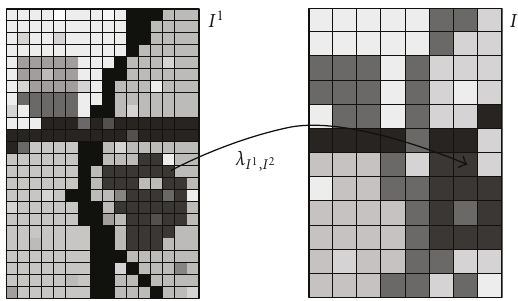
Figure 7: The function λ I 1 , I 2 is the association function between two images. It enables to associate one pixel of the image I 2 to each pixel of the image I 1 .